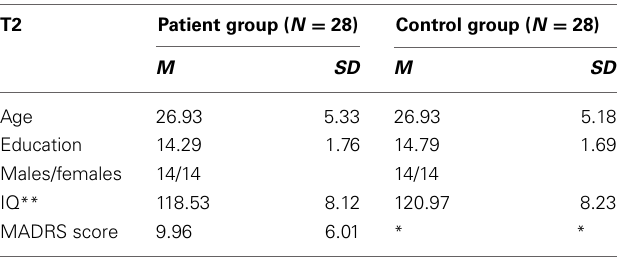
Table 1 | Descriptive data for the patient group and the control group at